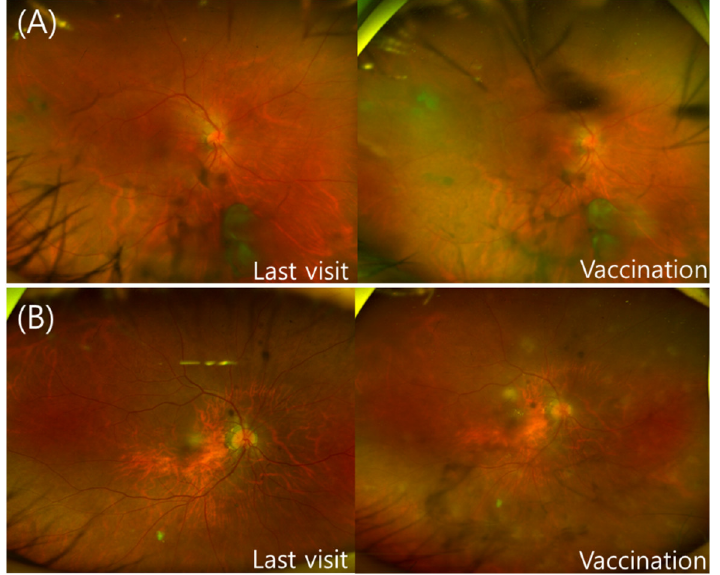
Figure 2. ( A ) (Patient 11) A 62-year-old man, previously diagnosed with panuveitis with human leukocyte antigen B51 positivity and who was taking an oral steroid and cyclosporin ( Left ), shows well-controlled uveitis, although vitreous opacity remains (visual acuity 20/40). ( Right ) The patient reported a decrease in visual acuity (VA) in the right eye one day after AZD1222 inoculation, documented as 20/100. An increase in vitreous opacity in the right eye was confirmed during fundus examination, and keratic precipitates and inflammatory cells in the anterior chamber during the slit-lamp examination were observed. ( B ) (Patient 12) The disease of a 79-year-old woman, who was diagnosed with panuveitis 20 years prior and undergoing follow-up, was well-controlled without topical and systemic medications (right eye VA 20/63). ( Left ) A relatively clear vitreous without signs of inflammation during fundus examination was observed at the last visit. ( Right ) The patient was inoculated with BNT162b2, and three days later, she complained of decreased VA in the right eye (20/200) and stiff pain in both eyes. During fundus examination, vitreous opacity and focal retinal infiltration were observed in her right eye.